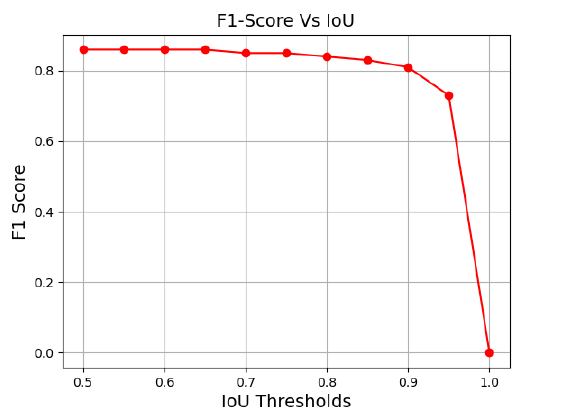
Figure 11. The detection results for the SR-CNN model on the PubLayNet [44] dataset. The first image highlights a true positive example, and the second image highlights a false positive example.